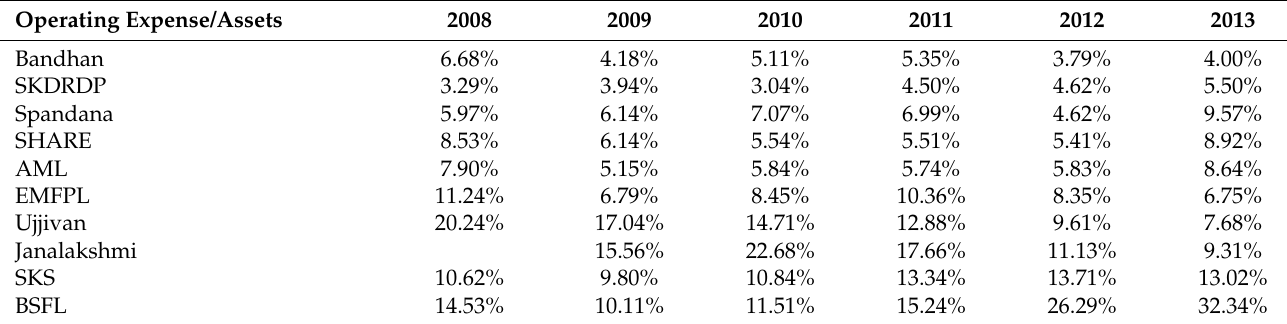
Table A4. Operating Expenses of Top Indian